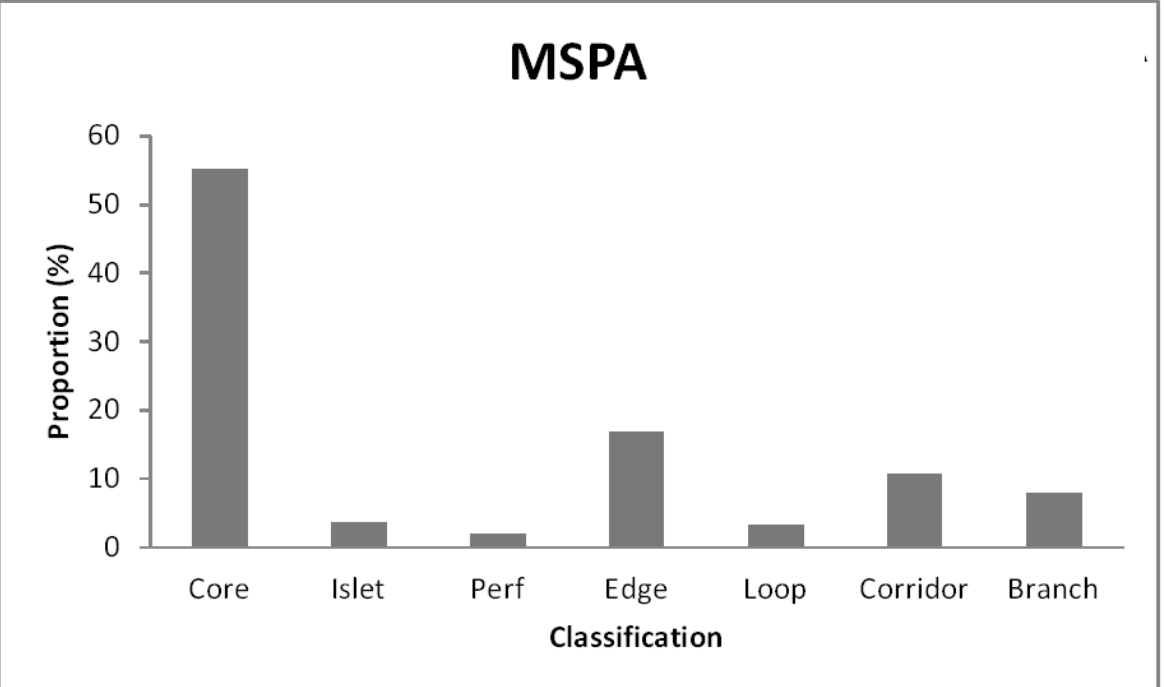
Figure 1. Proportion and classification of the forest remnants for the Belém area of endemism based on the MPSA